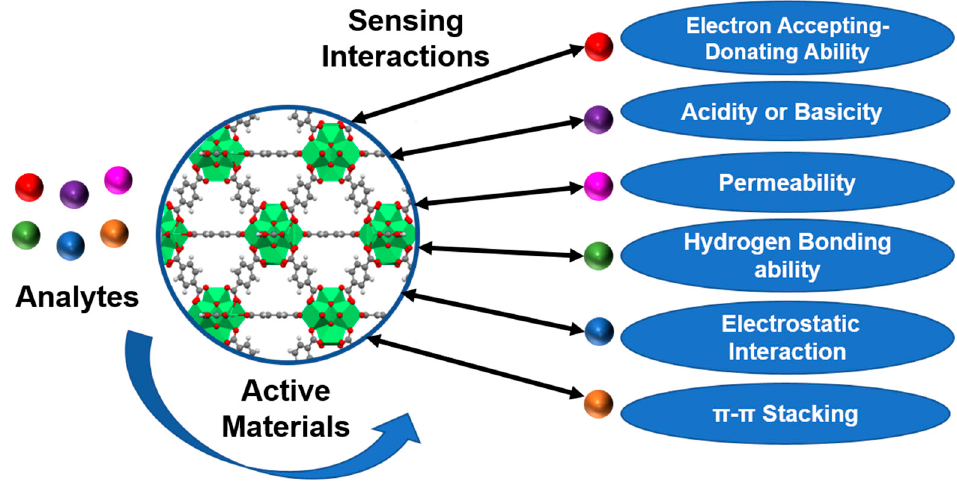
Figure 1. A schematic illustration of the interactions involved in the detection of various analytes.